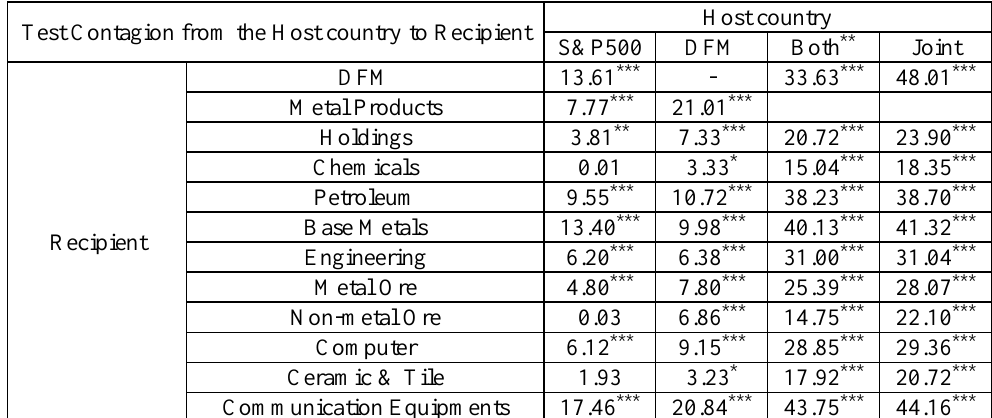
Table 5-3. DFGM Contagion Test